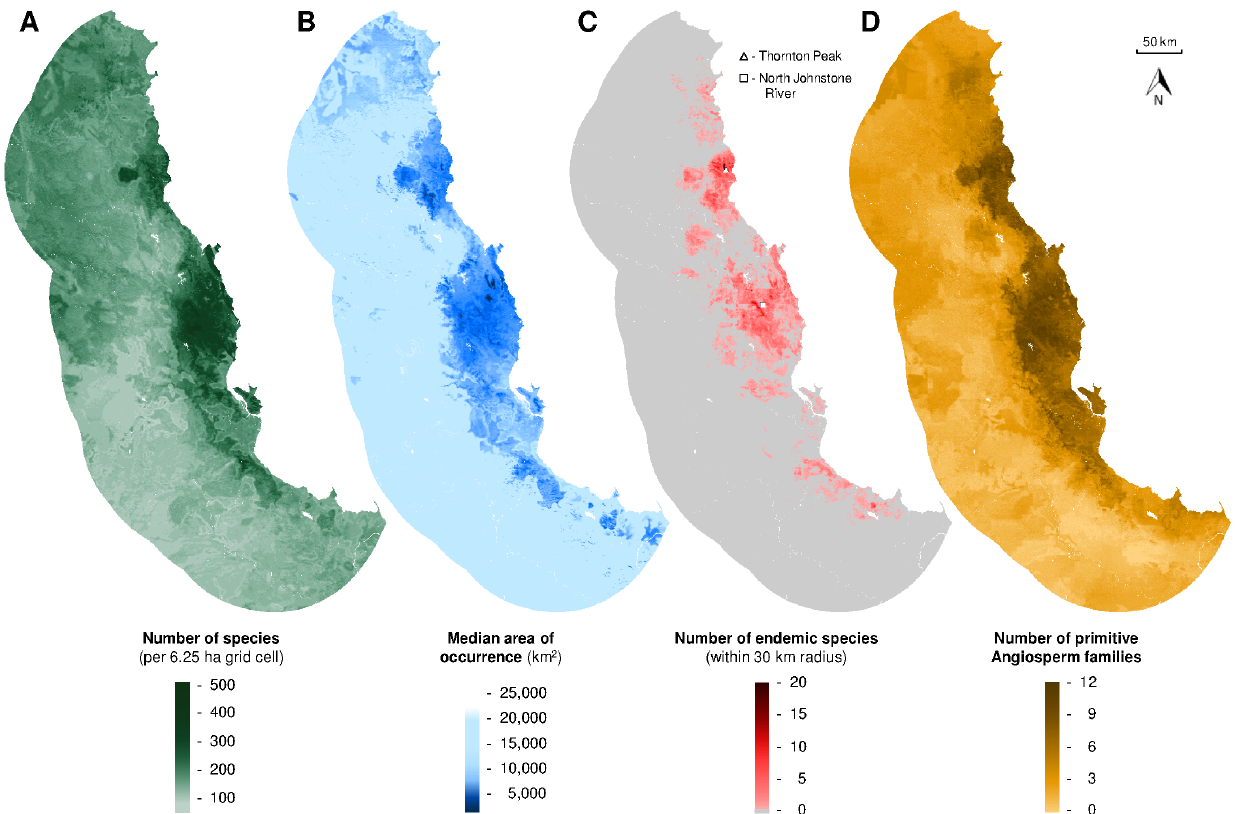
Figure 3. Predicted plant diversity attributes. Predictions across the study region of: ( A ) species richness; ( B ) median area of occurrence of species within each community; ( C ) the number of species present that are endemic to a circular area of radius 30 km centred on each community, and; ( D ) the number of primitive angiosperm families represented in each community (250 m grid cell). doi:10.1371/journal.pone.0089084.g003 PLOS ONE |